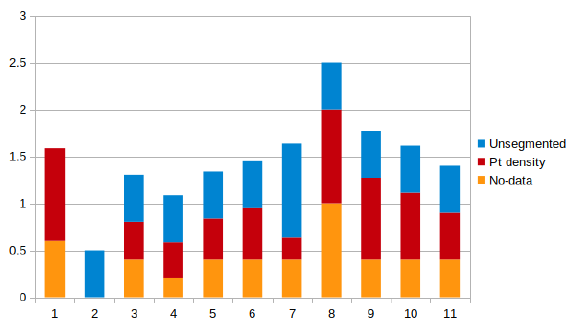
Figure 6 . Median point cloud statistics per acquisition region (Figure 5). The values are relative and transformed so that a higher value means better properties.